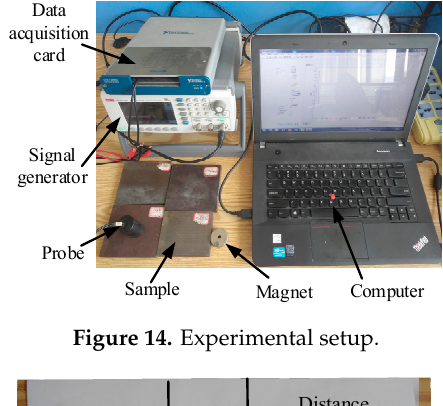
Figure 14. Experimental setup.